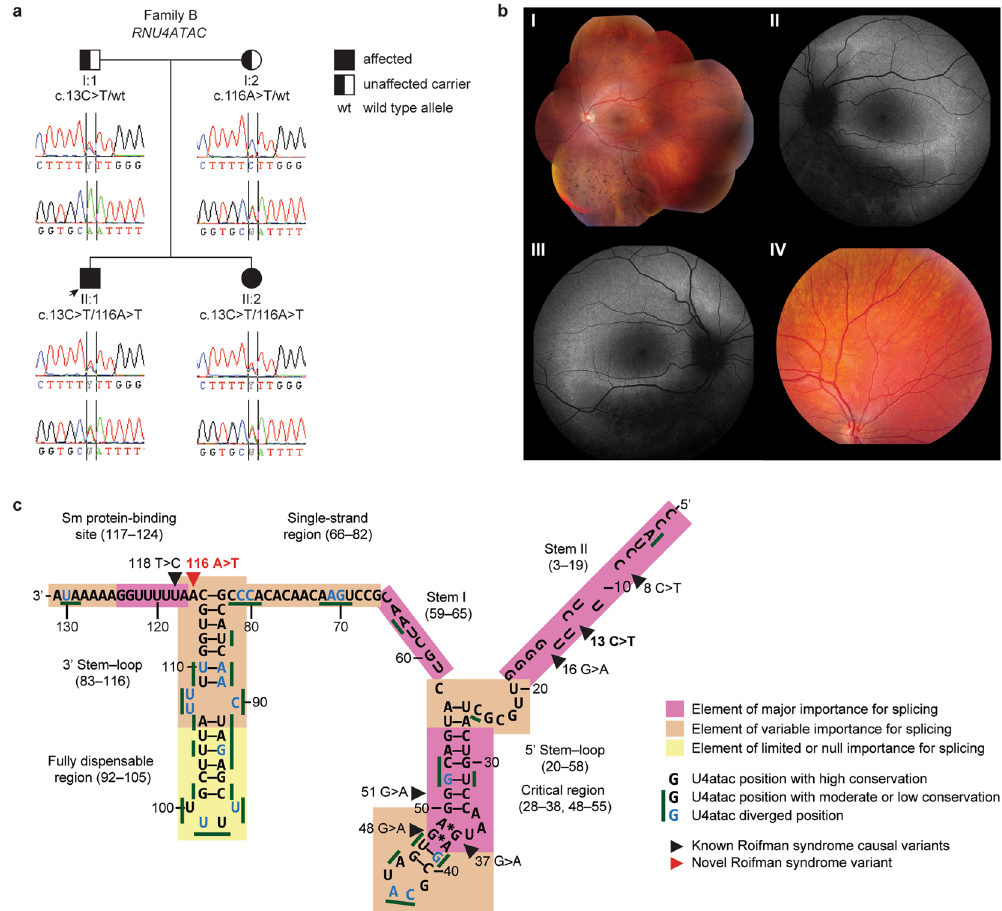
Figure 2. Family B with RNU4ATAC -associated Roifman syndrome (RS). ( a ) Pedigree of family B. ( b ) Representative retinal images of the RS patients. Panel I, composite retinal image of fundus of left eye (LE) of patient II:1: note inferior outer retinal atrophy with greyish hue and intraretinal pigment migration of the spicular type in inferior retina; mottled aspect of retinal pigment epithelium, more pronounced in inferotemporal area. Panel II, blue light autofluorescence image of LE of patient II:1 showing hyperautofluorescent delineation of inferior atrophic zone, as well as superior to optic disc, illustrating more widespread disease than can be seen on white light fundoscopic image only. Panel III, similar image of right eye (RE) of patient II:1 as in Panel II. Panel IV, fundus picture of detail of superonasal midperiphery of RE of patient II:2. Despite a normal full-field flash electroretinography, recent fundus examination at 14 years of age showed a mild mottling of pigment epithelium suggestive of early stage retinal dystrophy. ( c ) U4atac snRNA showing structural elements, conserved positions and location of variants associated with RS (adapted from ref. 8). The here-reported variant that has not been previously associated with RS is shown in